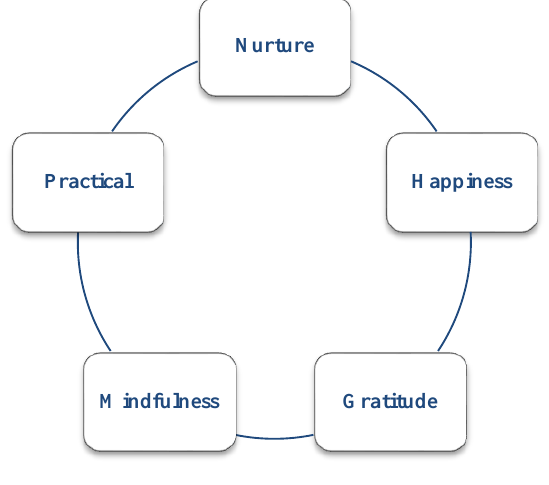
Figure 4. Circle of five concepts